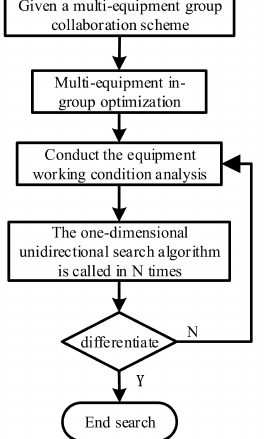
Figure 2. Flow chart for MEC packet.